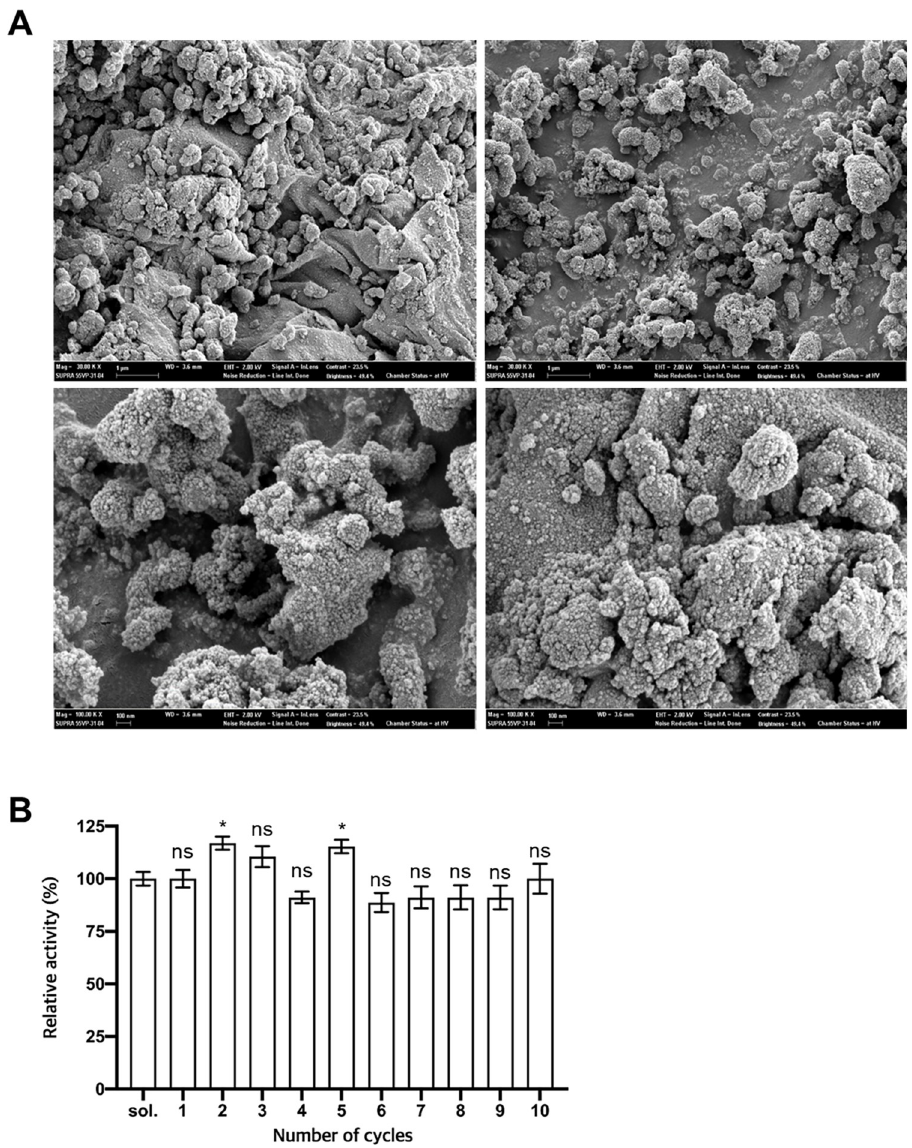
Fig 6. Immobilization of Lg EstI and activity. (A) Scanning electron microscope (SEM) image of Lg EstI-CLEAs. Representative images at 30 kX (upper) and 100 kX (lower) are shown. (B) The reusability of Lg EstI-CLEAs was assessed by measuring residual activity after repeated washing. p NA was used as a substrate and the activity of soluble Lg EstI was defined as 100%. Statistical significance ( p values) was calculated using a t -test. P values were indicated by ns, not significant (P > 0.05), and � (p <